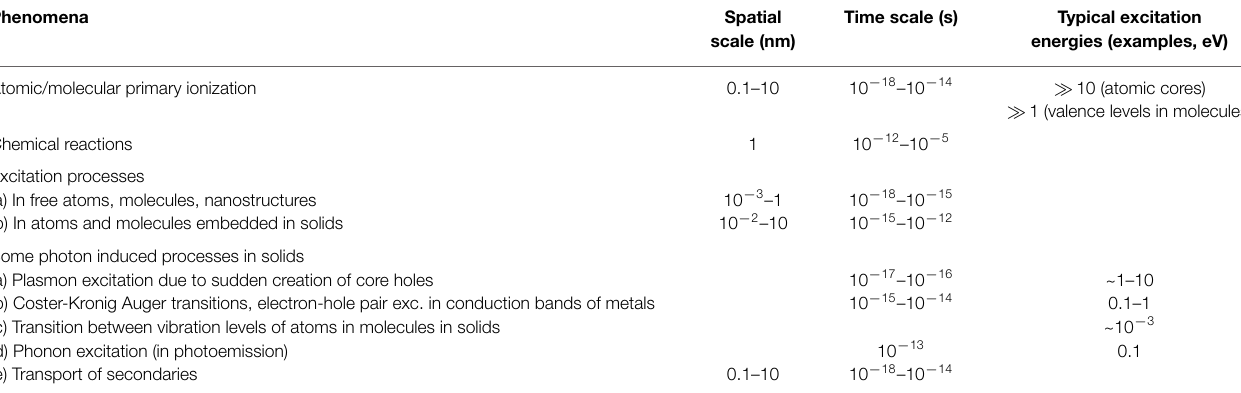
Time scale (s) Typical excitation scale (nm) energies (examples, eV)